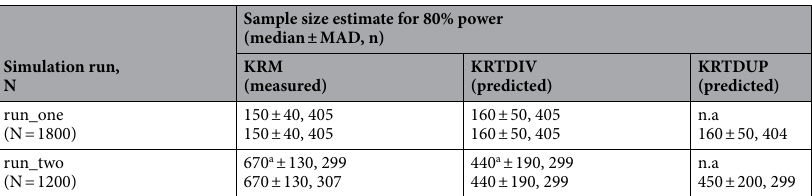
Table 3. Predicted (trial KRTDIV or KRTDUP algorithms) and measured (MEASURE) sample sizes for 80% power using Monte-Carlo Kruskal-Wallis tests, with samples derived from simulated populations for which ANOVA would be either difficult or impossible to process. Results from all Pearson types pooled from data for which ANOVA trial (ANT) predicted sample sizes were missing (either because of failure or not processed). KRM Kruskal-Wallis, measured; KRTDIV Monte-Carlo Kruskal-Wallis trial, predicted (division algorithm); KRTDUP Monte-Carlo Kruskal-Wallis trial, predicted (duplication algorithm); See Table 1 for descriptions of simulation runs. N = original number of samples; Median and MAD = median absolute deviation around the median (R mad(constant = 1) ) to two significant figures: for each run the first rows of numbers are for statistical comparisons between KRTDIV and KRM (samples were removed if either of these had missing values; n = number of samples remaining), second rows include values from all samples, regardless of whether one parameter gave a missing value (n = number of non-missing values). run_one: no significant difference between KRTDIV and KRM medians by Brown-Mood median tests; run_two a Z = − 7.36, p = 1.89 × 10 −13 . n.a. = not